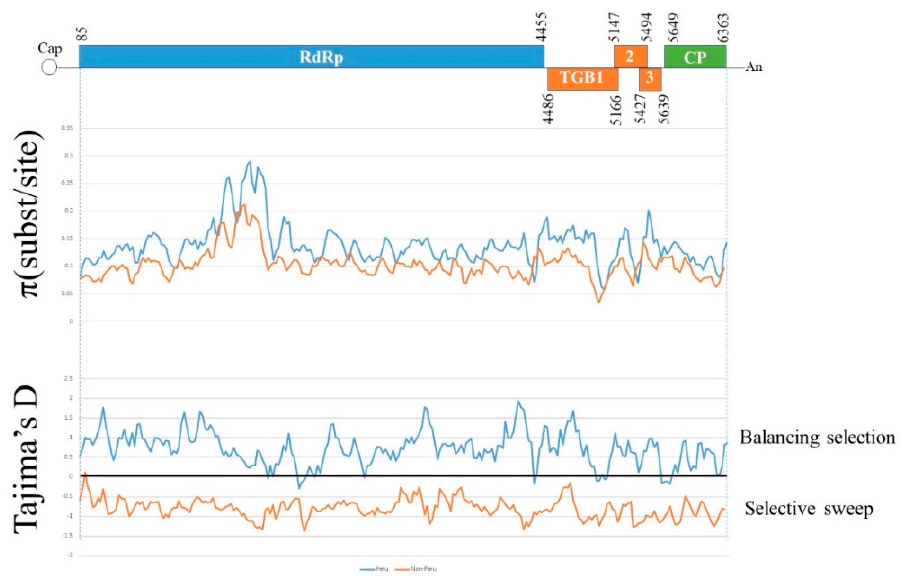
Figure 3. The mean genetic diversity of the aligned concats from 322 (Peruvian, blue) and 47 (non- Peruvian, red) potato virus X genomes. Estimates of π (substitution/sites) and of Tajima ′ s D metric were made in a window of 100 nts with a step of 25 nts.